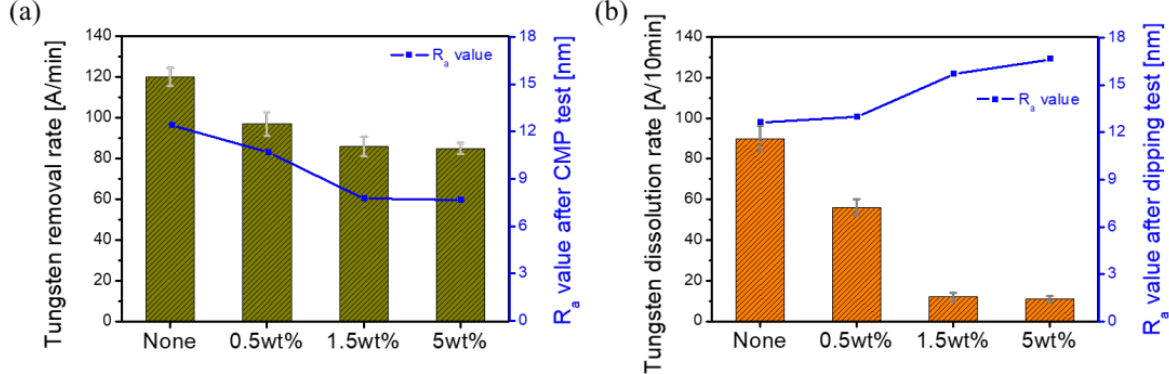
Figure 4. ( a ) Dissolution rates and R a values from the tungsten dipping test and ( b ) removal rates and R a values from the tungsten CMP test for various picolinic acid concentrations.